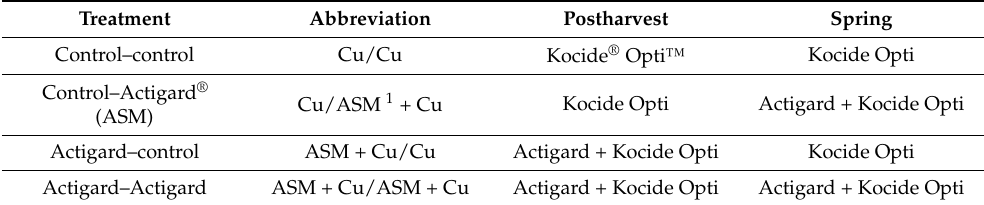
Table 5. Treatment combinations to Actinidia chinensis var. deliciosa “Hayward” and in A. chinensis var. chinensis “Zesy002” kiwifruit vines over postharvest and spring in 2021. Treatment Abbreviation Postharvest Spring